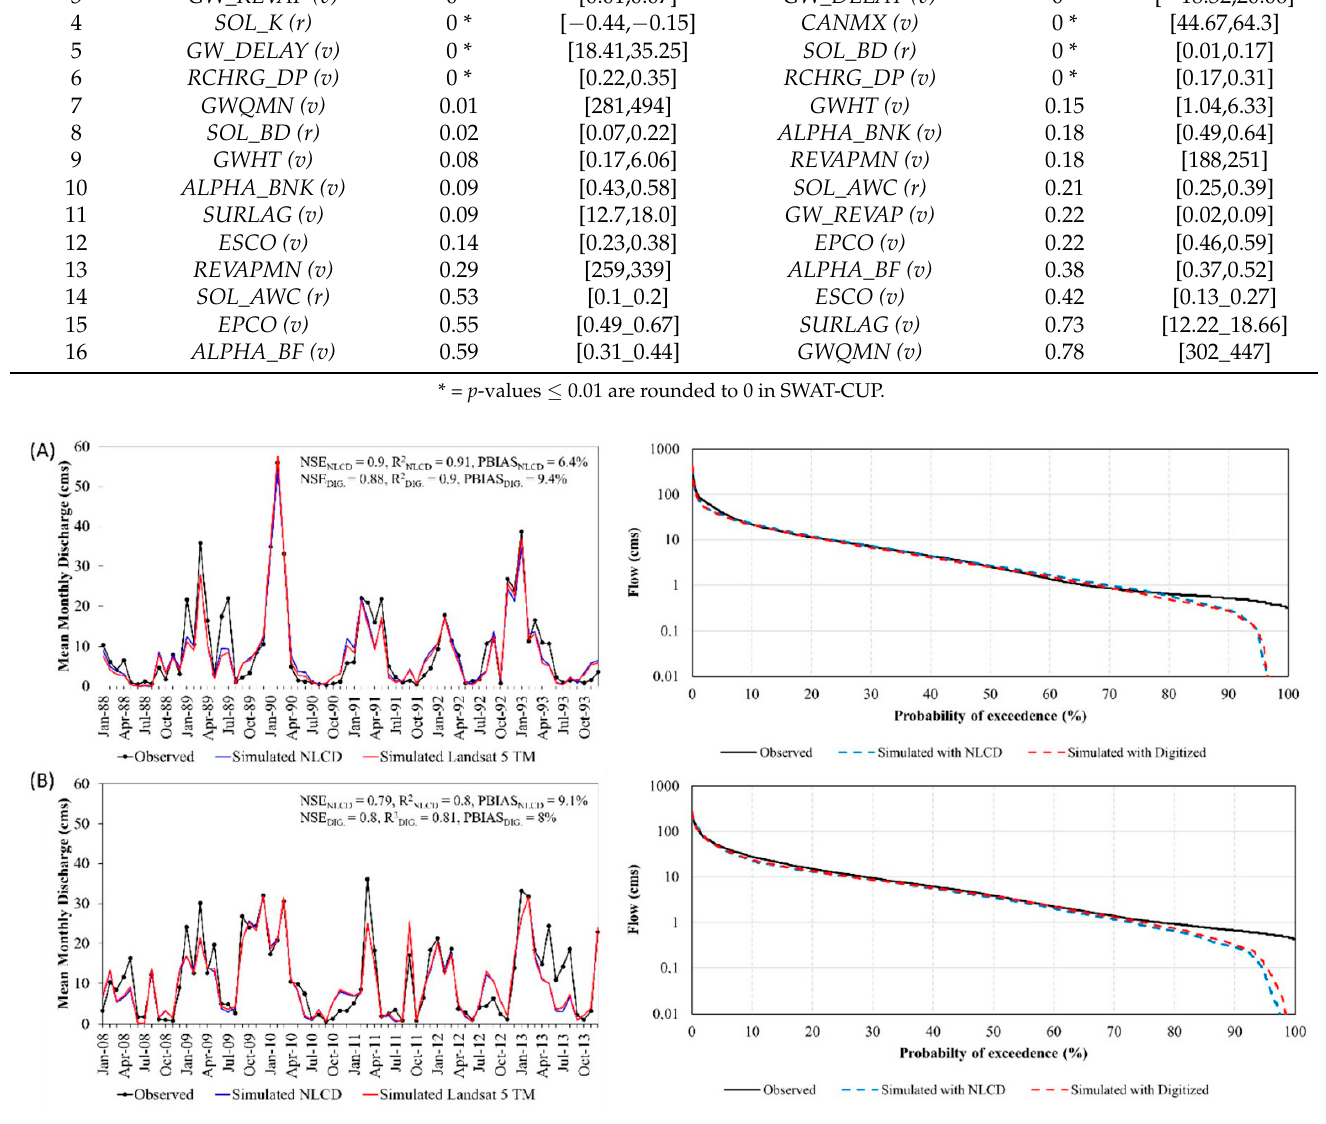
Figure 3. Observed and simulated mean monthly streamflows and daily flow duration curves during the ( A ) calibration and ( B ) validation periods. Table 7. Calibration and validation